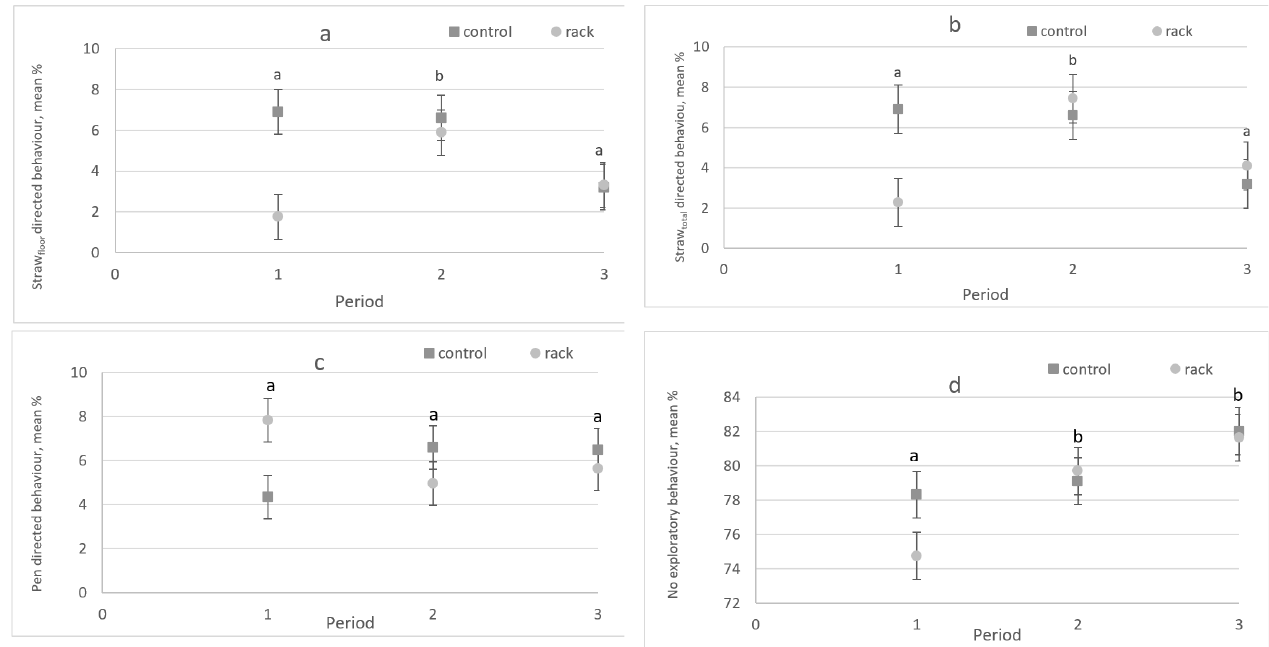
Figure 4. Levels of different exploratory behaviours the production periods. Different letters (a, b) indicate significant difference between different periods. ( a ) Levels of straw floor -directed behaviour over time. The treatment and the interaction between treatment and period had a significant effect ( N = 30). ( b ) Levels of straw total -directed behaviour (a combination of the interaction with straw on the floor and straw in the racks) over time. The treatment and the interaction between treatment and period had a significant effect ( N = 30). ( c ) Levels of pen-directed behaviour over time. The interaction between treatment and period had a significant effect ( N = 30). ( d ) Levels of non-exploratory behaviour over time. The period had a significant effect on the behaviour ( N = 30).